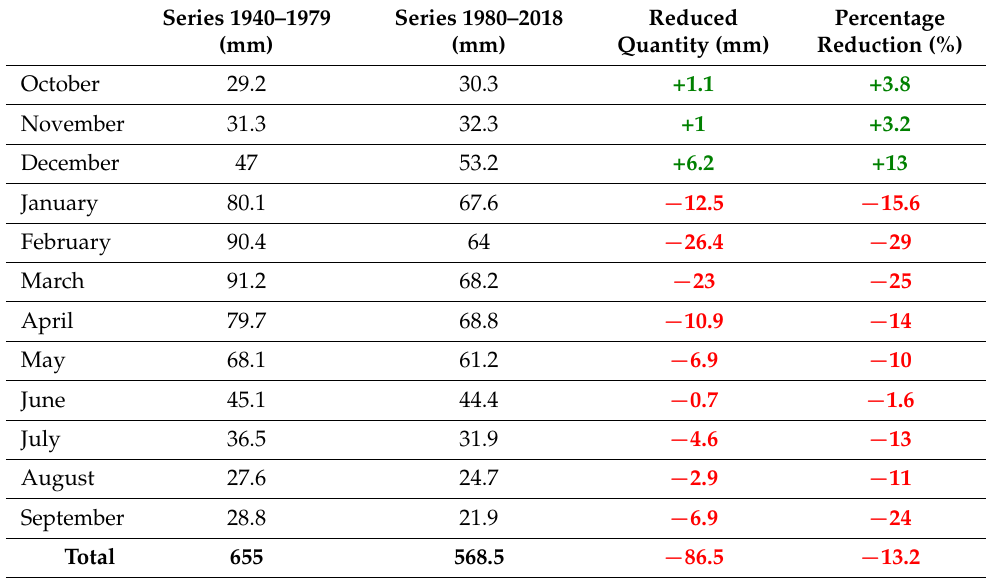
Table 2. Calculations of average monthly/annual precipitation decrease and percentages in the Upper Tagus (series 1940–1979 and